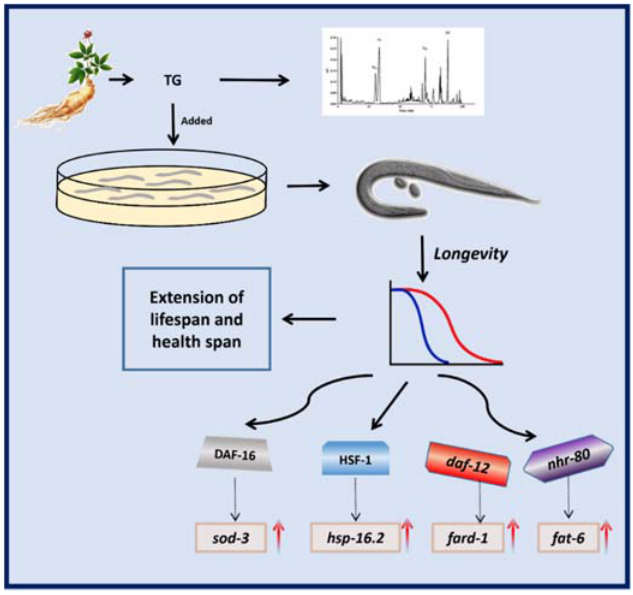
Figure 11. Schematic representation of the mechanism of the TG-extended lifespan. Supplementary Materials: The following are available online at www.mdpi.com/xxx/s1, Table S1. All the strains used in this study. Table S2. A list of the primers used for the quantitative real-time reverse transcription-polymerase chain reaction. Table S3. The lifespans of N2 and mutant C. elegans .